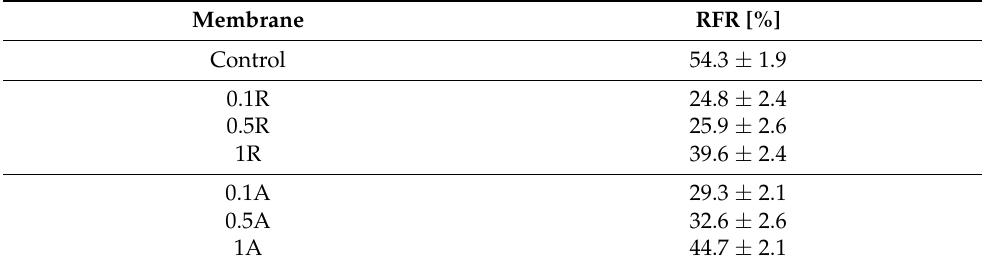
Table 5. Relative flux reduction of the studied